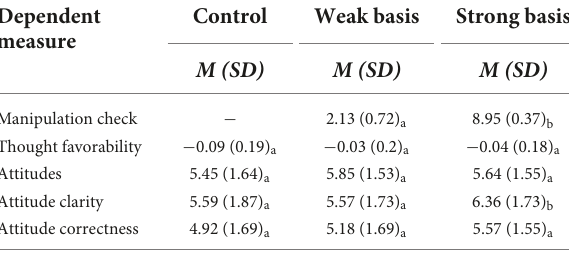
TABLE 1 Study 1 means and standard deviations for the relevant dependent measures as a function of the value basis condition. Dependent